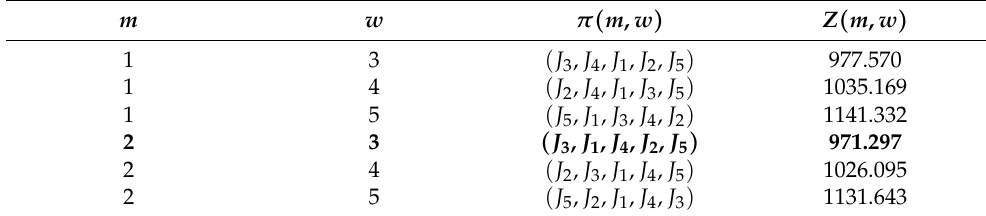
Table 5. Results of problem P 2 (bold numbers are the optimal